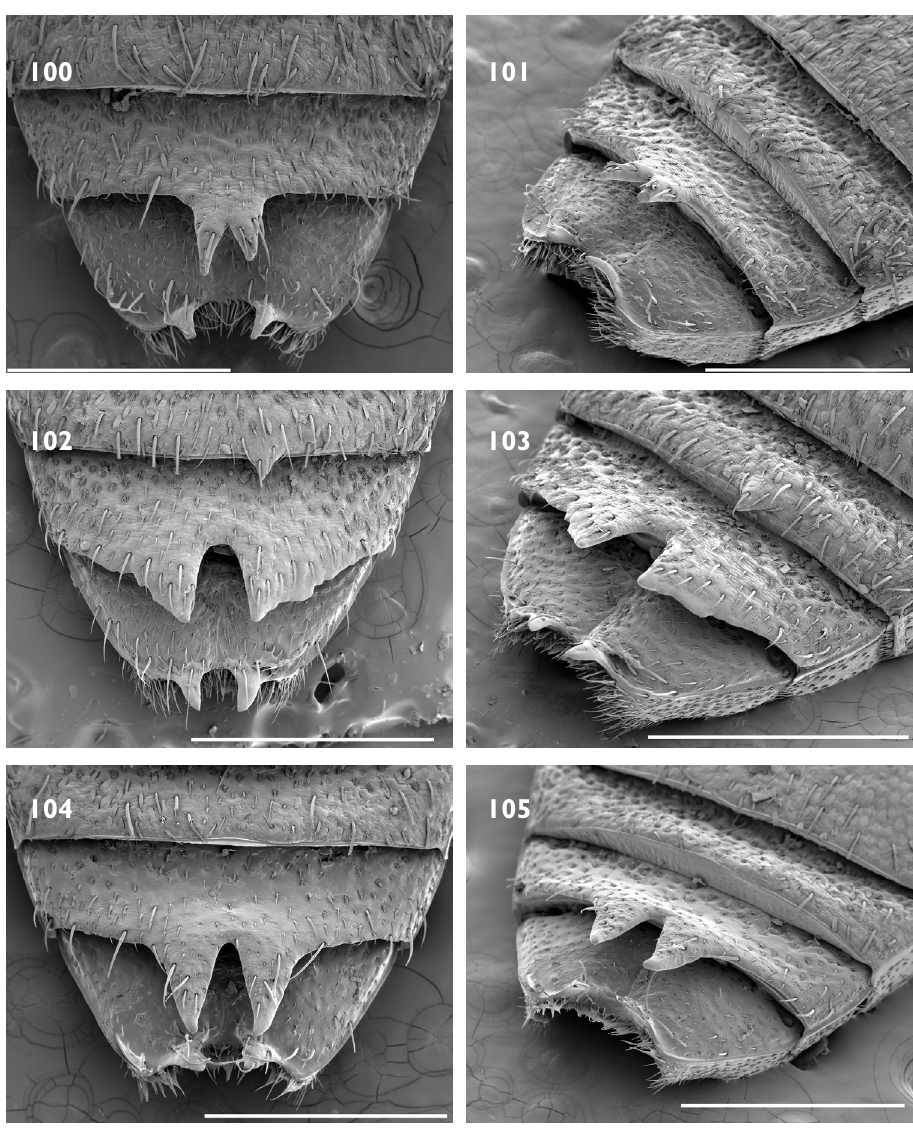
Figures 100–105. SEM photographs of abdominal ventrites 4 and 5 of Austromonticola females. 100, 101 A. atriarius 102, 103 A. furcatus 104, 105 A. mataura . Left: ventral view. Right: ventroposte- rolateral view. Scale bars = 0.5